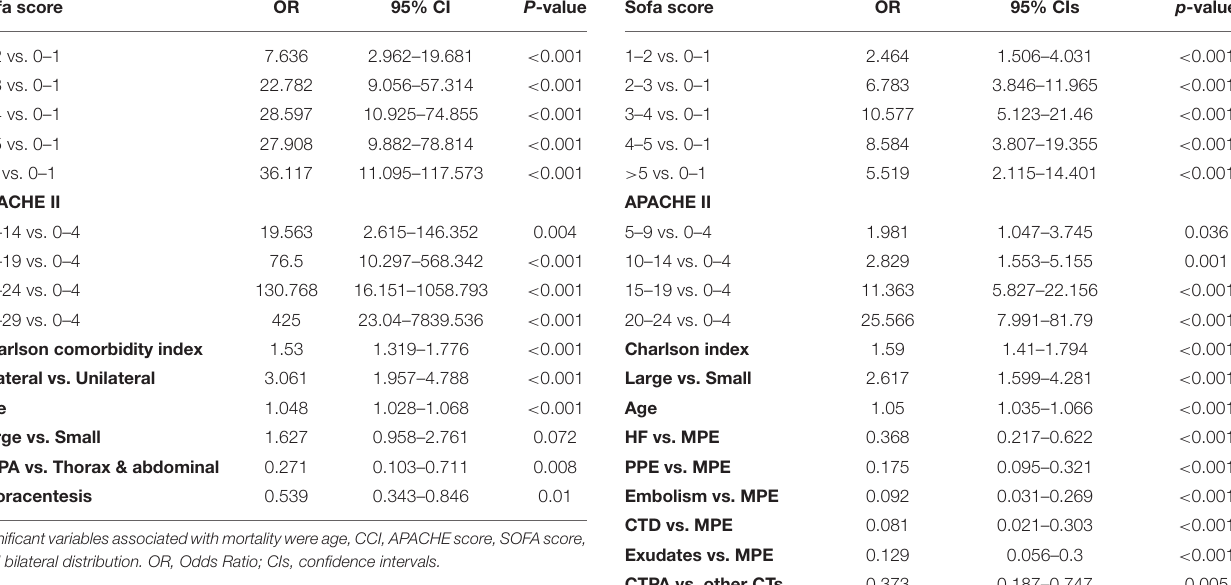
TABLE 4 | Univariate predictors of mortality at 1 year. Sofa